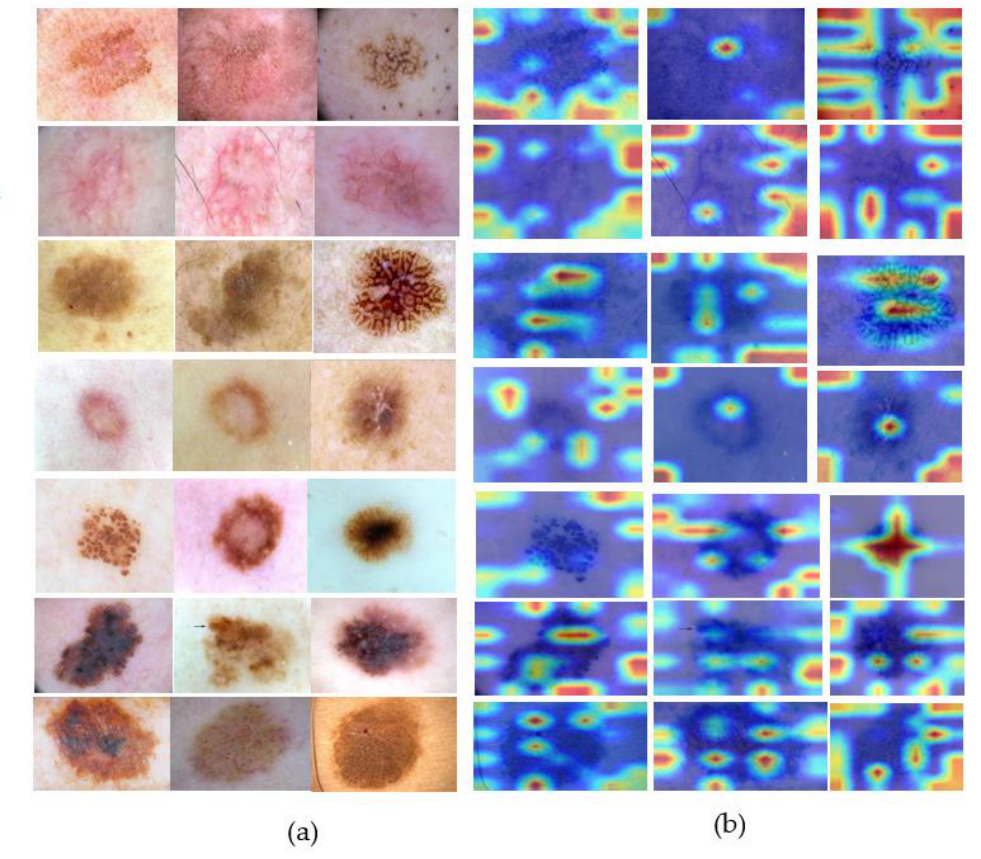
Figure 15. A visual impact of classification results of the proposed ShuffleNet-Light model by GradCAM with the greatest prediction probability for each category among the test set samples. In this figure, ( a ) is the original input sample, and ( b ) is the GradCAM map.